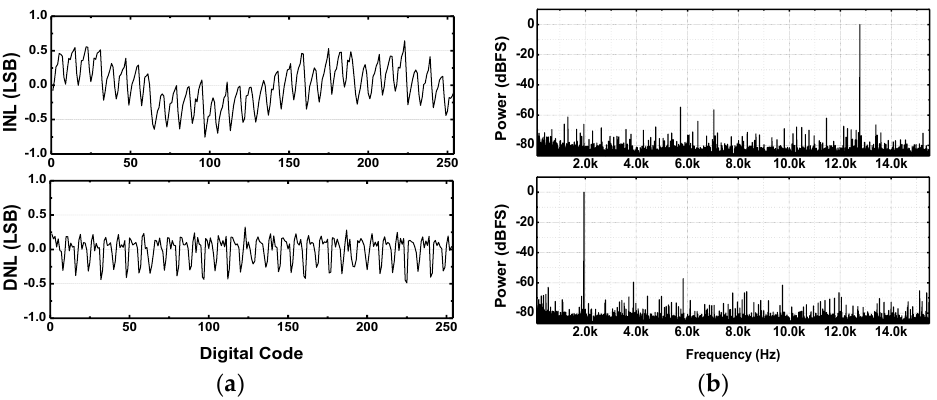
Figure 16. Measured SAR ADC characteristics: ( a ) INL/DNL and ( b ) FFT output spectra for 1.9474 kHz and 12.7621 kHz input signals at the sampling frequency of 31.25 kS/s.